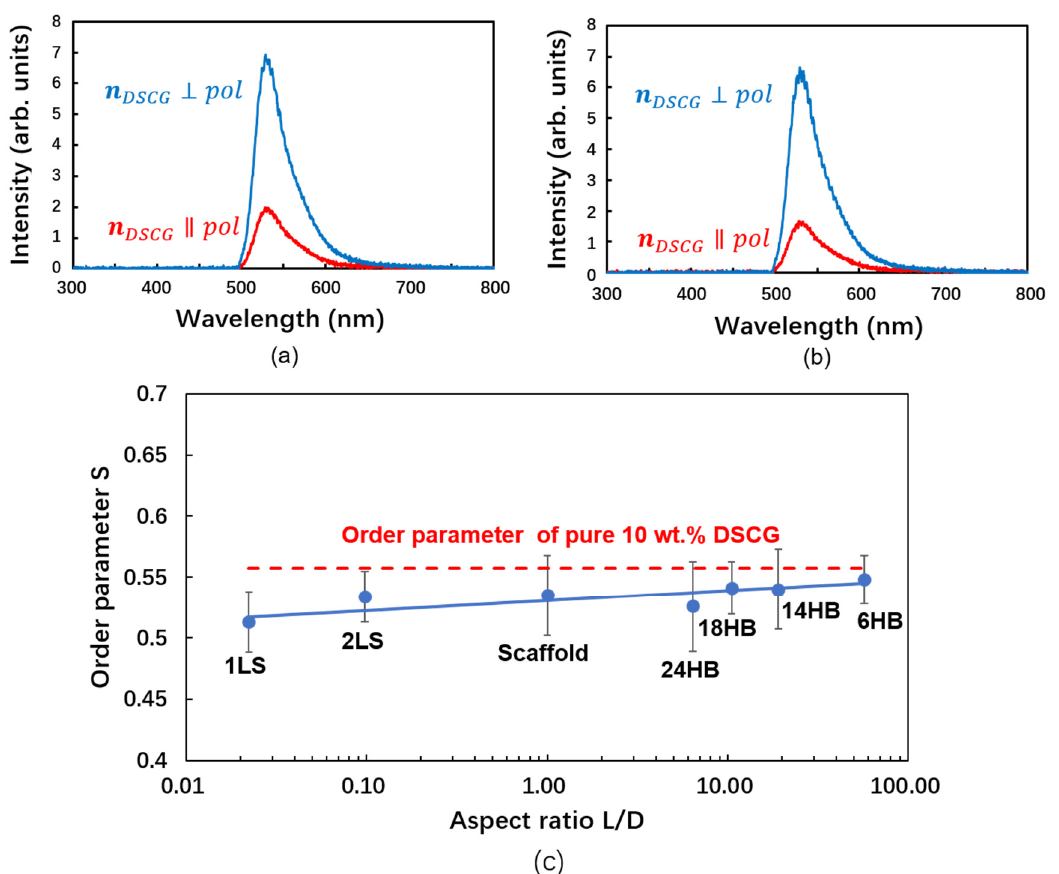
Figure 4. Fluorescence dichroism and order parameter of DSCG solution and respective DNA–NP nanocomposites. ( a ) Polarized fluorescence spectra of 50 µM AO in the presence of 10 wt.% DSCG without any DNA nano-rods. ( b ) Polarized fluorescence spectra of 50 µM AO in the presence of 10 wt.% DSCG and 8.9 nM 24-helix bundles (24HB). The striking similarity of the fluorescence intensities observed for DSCG samples ( a ) without DNA–NPs and ( b ) with DNA–NPs reveals that the presence of small amounts of DNA–NPs does not affect the fluorescence dichroism, which indicates the alignment of the DSCG aggregates. ( c ) Order parameter of DSCG versus aspect ratio of the DNA nanostructures that are added.